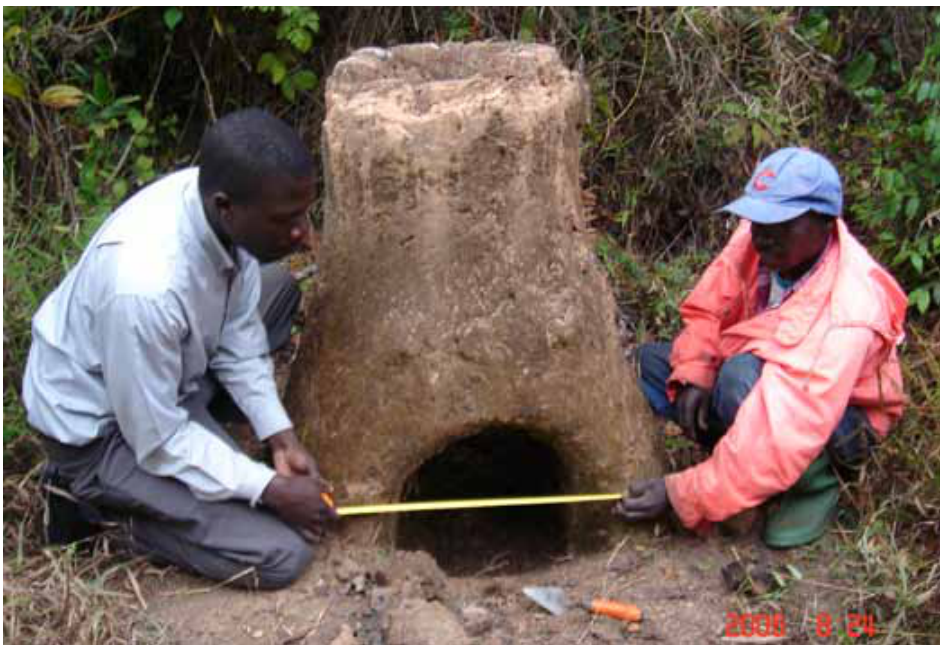
Fig 3: The intact iron smelting furnace at Mjimwema (SE2). Note that the section and plan of this furnace are represented in figure 6.